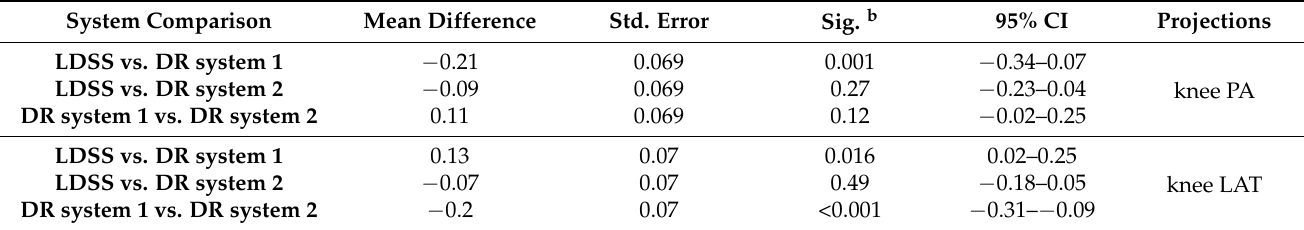
Table 13. Comparison of the mean VGA across the imaging systems in knee PA and LAT